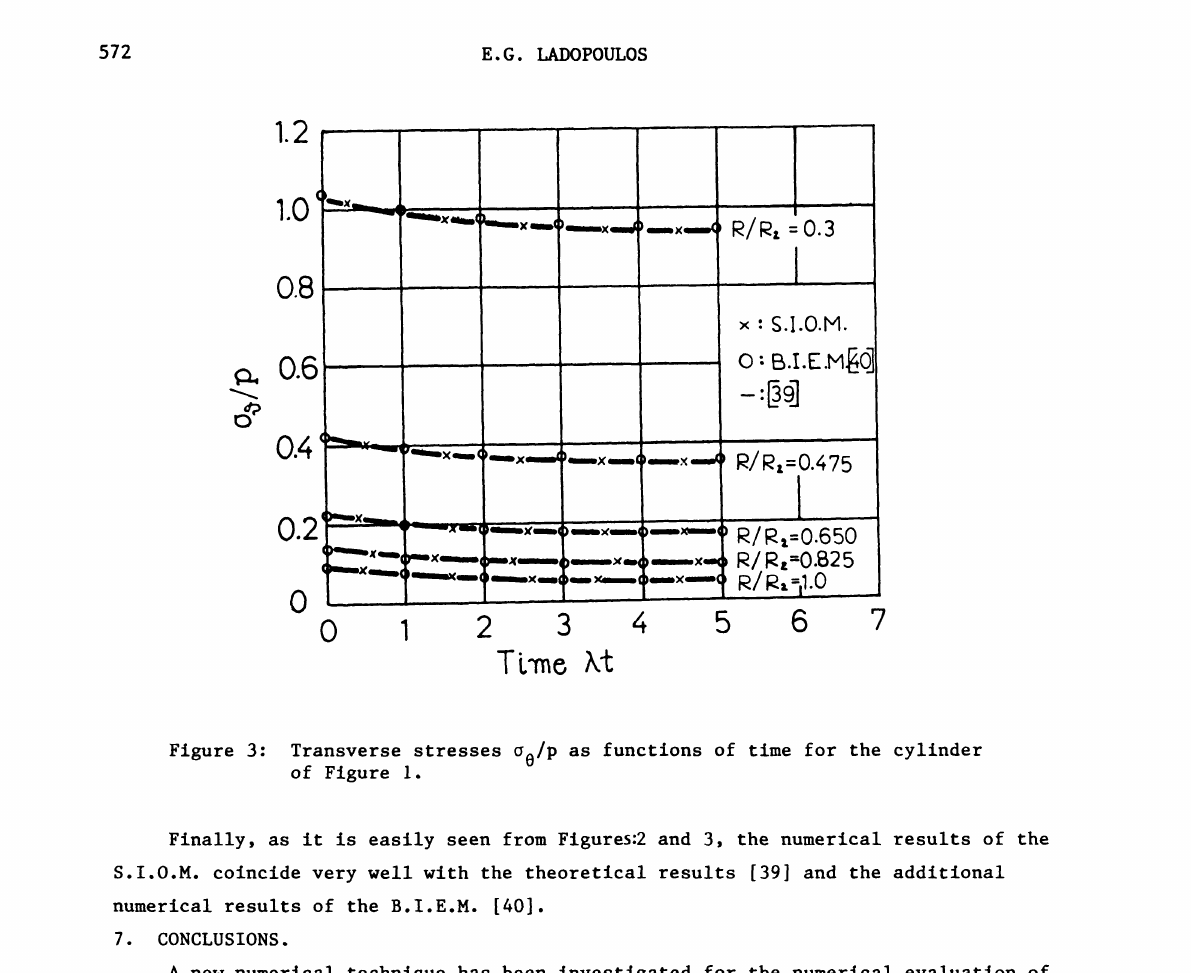
Figure 3: Transverse stresses o0/p as functions of time for the cylinder of Figure